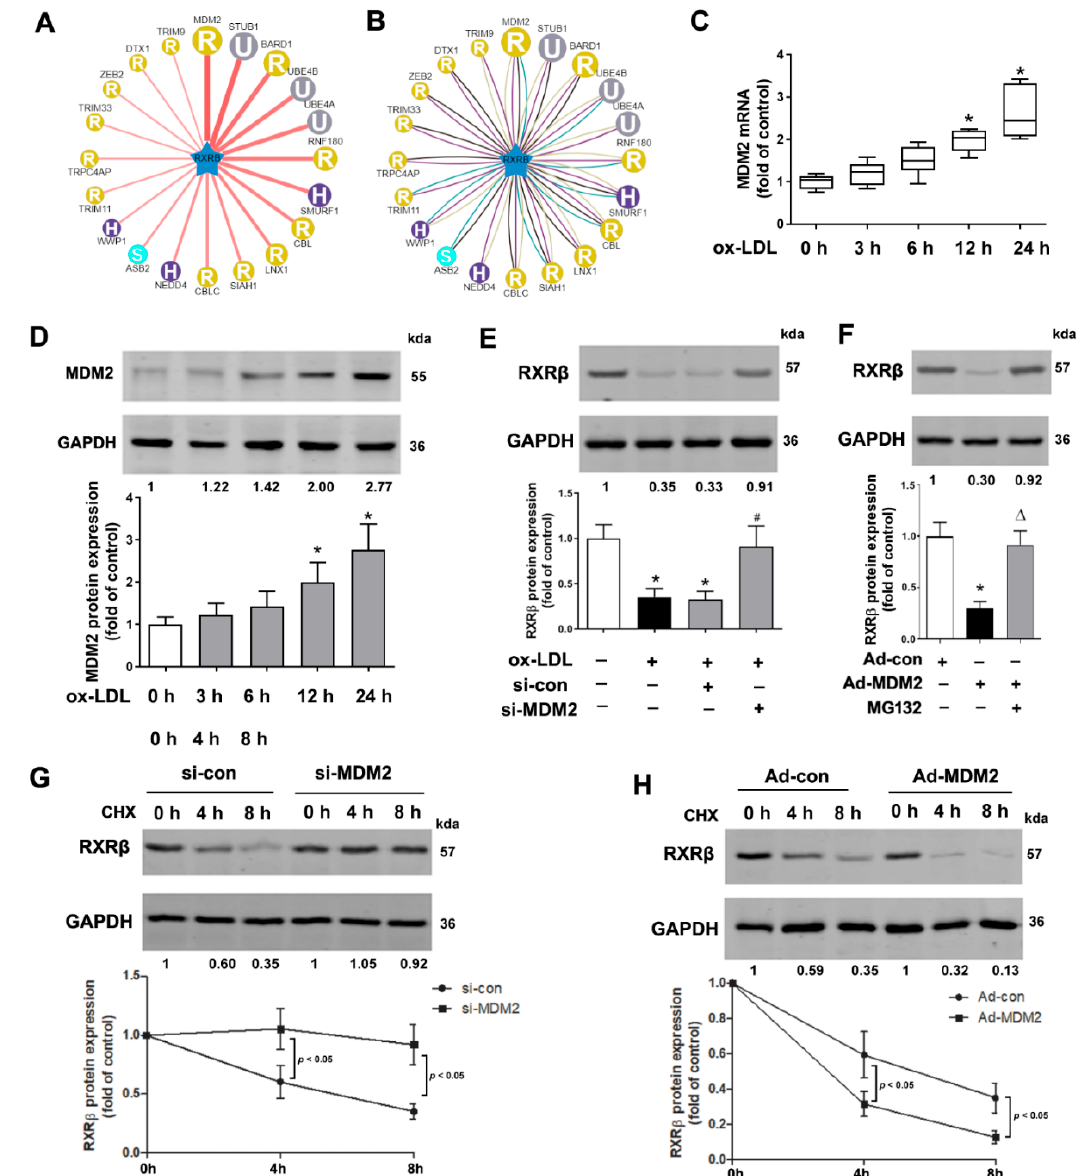
Figure 2. MDM2 can affect the stability of RXR β . ( A , B ) MDM2 is predicted as the specific E3 ligase of RXR β by the UbiBrowser database. In the confidence mode ( A ) and evidence mode ( B ), a node is positioned in the center of the canvas showing the putative substrates, surrounded by nodes revealing predicted E3 ligases. The node colors and characters denote the E3 ligase type with the edge width and node size representing the confidence score. ( C , D ) mRNA and protein expression of MDM2 in HAECs which were incubated with 100 μ g/mL ox-LDL at various times. ( E ) HAECs were incubated with control siRNA (si-con, 100 nM) or MDM2 siRNA (si-MDM2, 100 nM) for 24 h and then with 100 μ g/mL ox-LDL for additional 24 h. Then, the protein expression of RXR β in HAECs was determined. ( F ) HAECs were incubated with a non-targeting control vector (Ad-con) or MDM2-adenoviral vector (Ad-MDM2) in the presence and absence of MG132 (20 μ M) for 24 h. Then, the protein expression of RXR β in HAECs was determined. ( G , H ) Western blotting in lysates from HAECs transfected with si-MDM2, si-con, Ad-MDM2 or Ad-con in the presence of cycloheximide (100 μ g/mL) for up to 8 h. The results of Figure 2C were represented as median, 10th percentile, 90th percentile, and minimum and maximum values. The results of Figure 2D–H are presented as the mean ± SD. n = 6. * p < 0.05 vs. control group, # p < 0.05 vs. ox-LDL alone group, Δ p < 0.05 vs. Ad-MDM2 group.